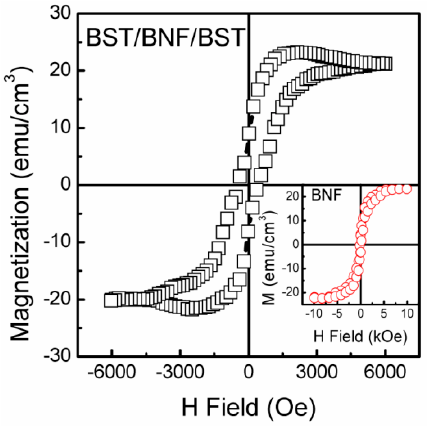
Figure 6. The M – H hysteresis loop of the BST / BNF / BST film on Pt(111) / Ti / SiO 2 / Si(100) substrate at room temperature, the inset is the M – H loop of single layer BNF thin film.